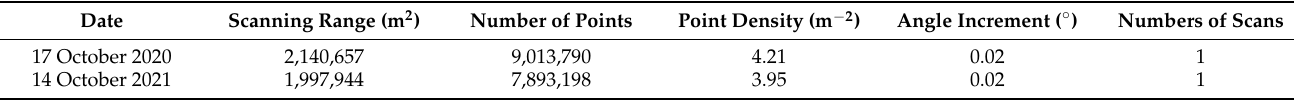
Table 1. Riegl VZ ® -6000 TLS surveying parameters of